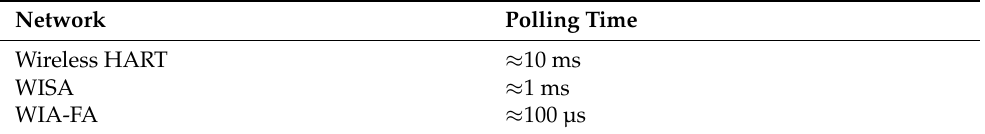
Table 2. Indicative Values of Device Polling Times for Industrial Wireless Networks. Network Polling Time Wireless HART WISA ≈ 1 ms WIA-FA ≈ 100